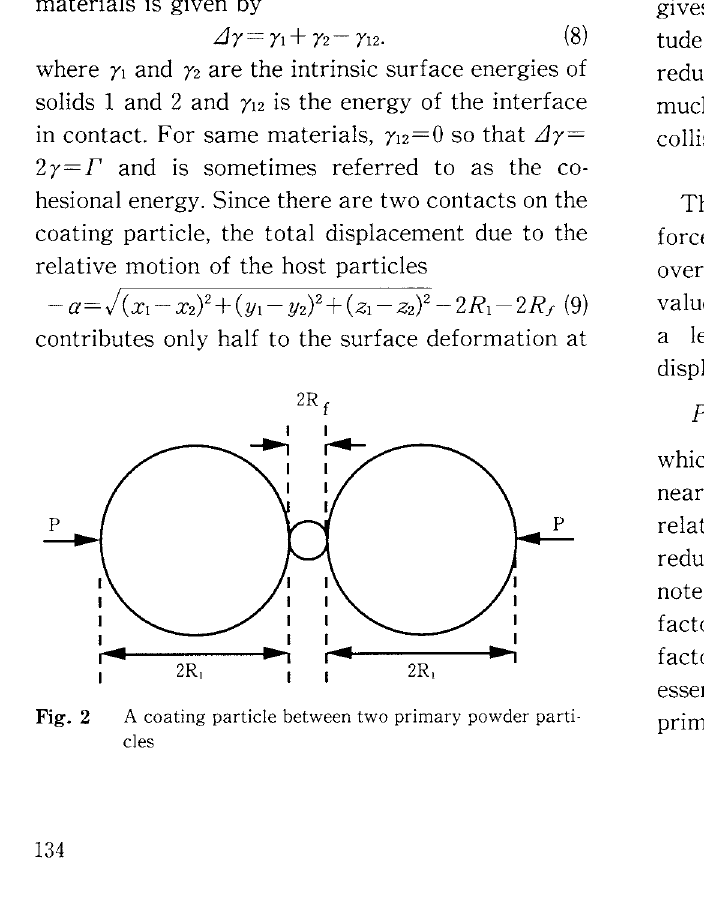
A coating particle between two primary powder